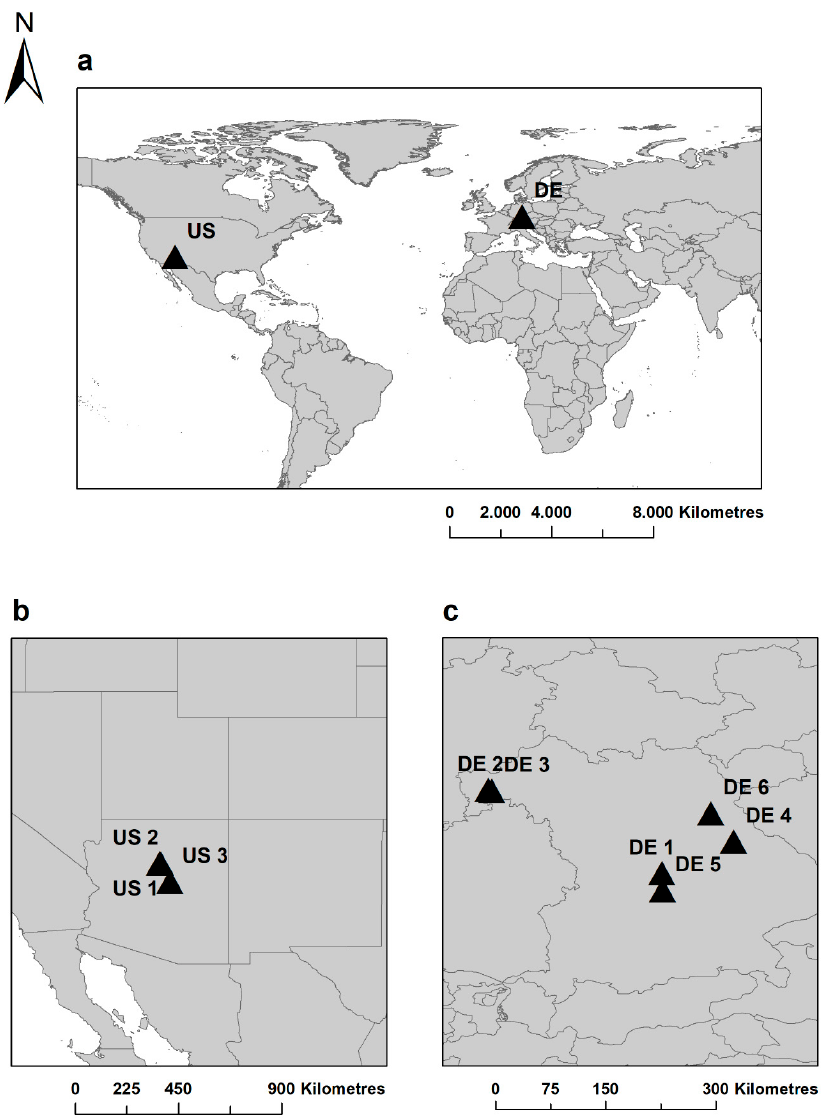
Figure 1. ( a ) Overview of study regions (black triangles) in Arizona, USA (US) and Bavaria, Germany (DE). ( b ) Detailed location (black triangles) of ponderosa pine study sites in Arizona (US 1–US 3). ( c ) Detailed location (black triangles) of sessile oak (DE 1–DE 3) and Scots pine study sites (DE 4–DE 6) in Bavaria.